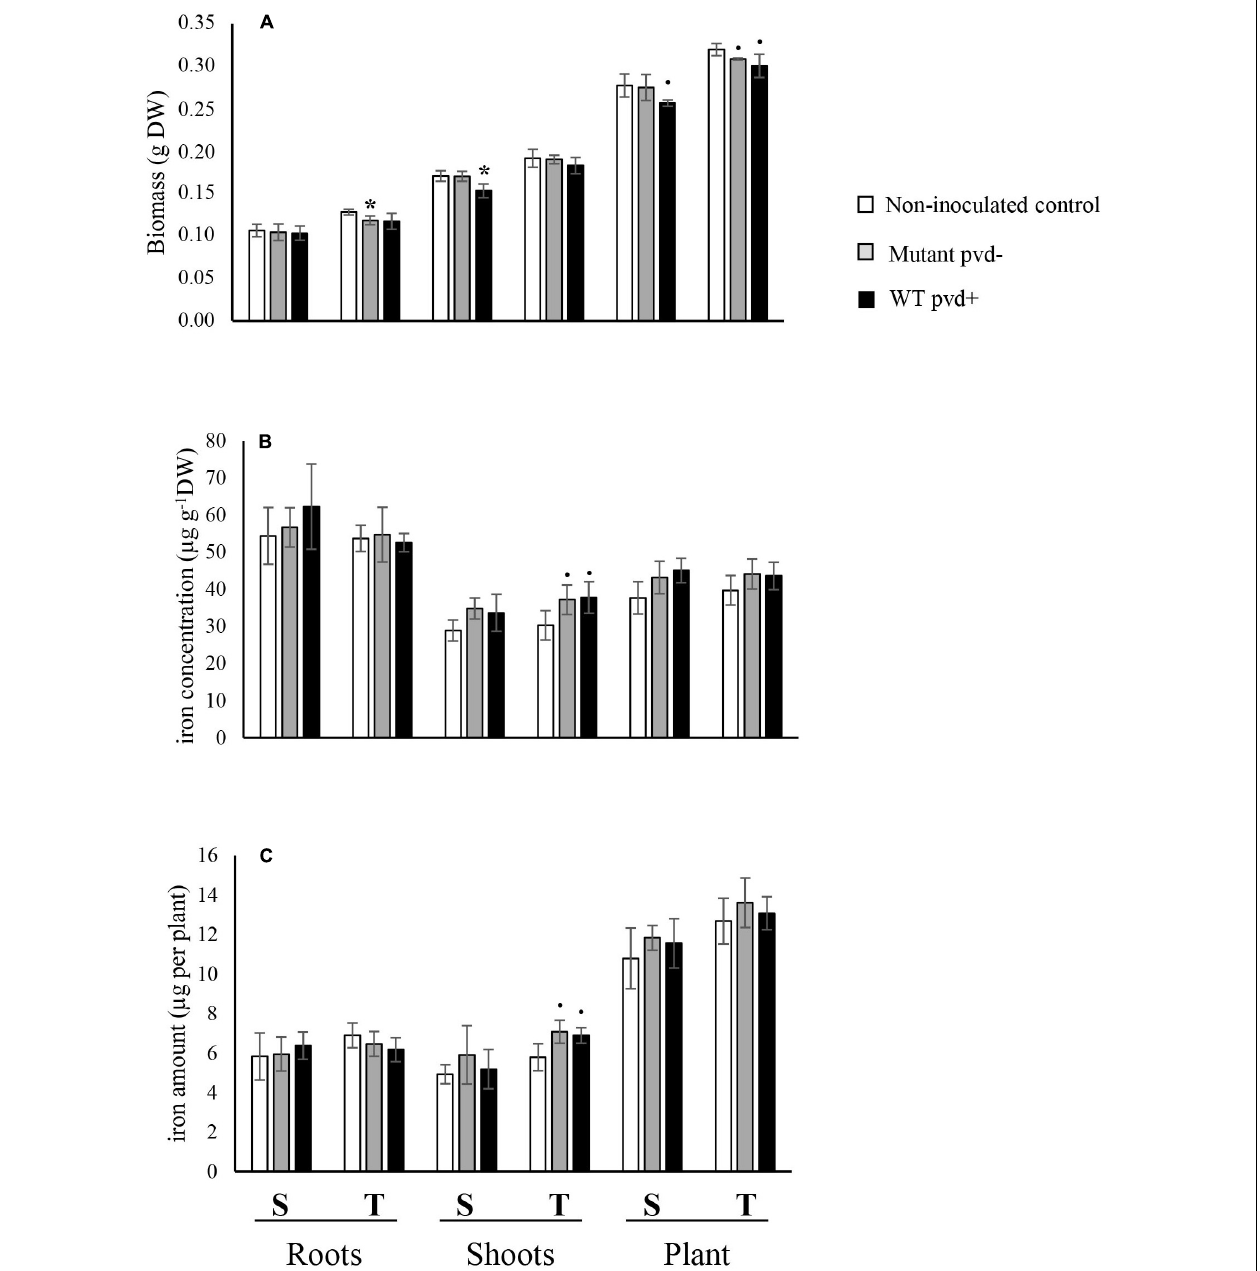
FIGURE 4 | Effect of inoculation of the wild type strain P. fluorescens C7R12 (WT pvd + ) and of PL1 its pvd − mutant (Mutant pvd − ) on (A) biomass, (B) iron concentration, and (C) iron content in two pea cultivars, tolerant (T) and susceptible (S) to iron chlorosis ( n = 3). Error bars represent the s.d. of the mean. P value was calculated using one-way ANOVA between the inoculation treatment and the non-inoculated control within a same plant compartment and in a same pea cultivar. • p < 0.1; * p <